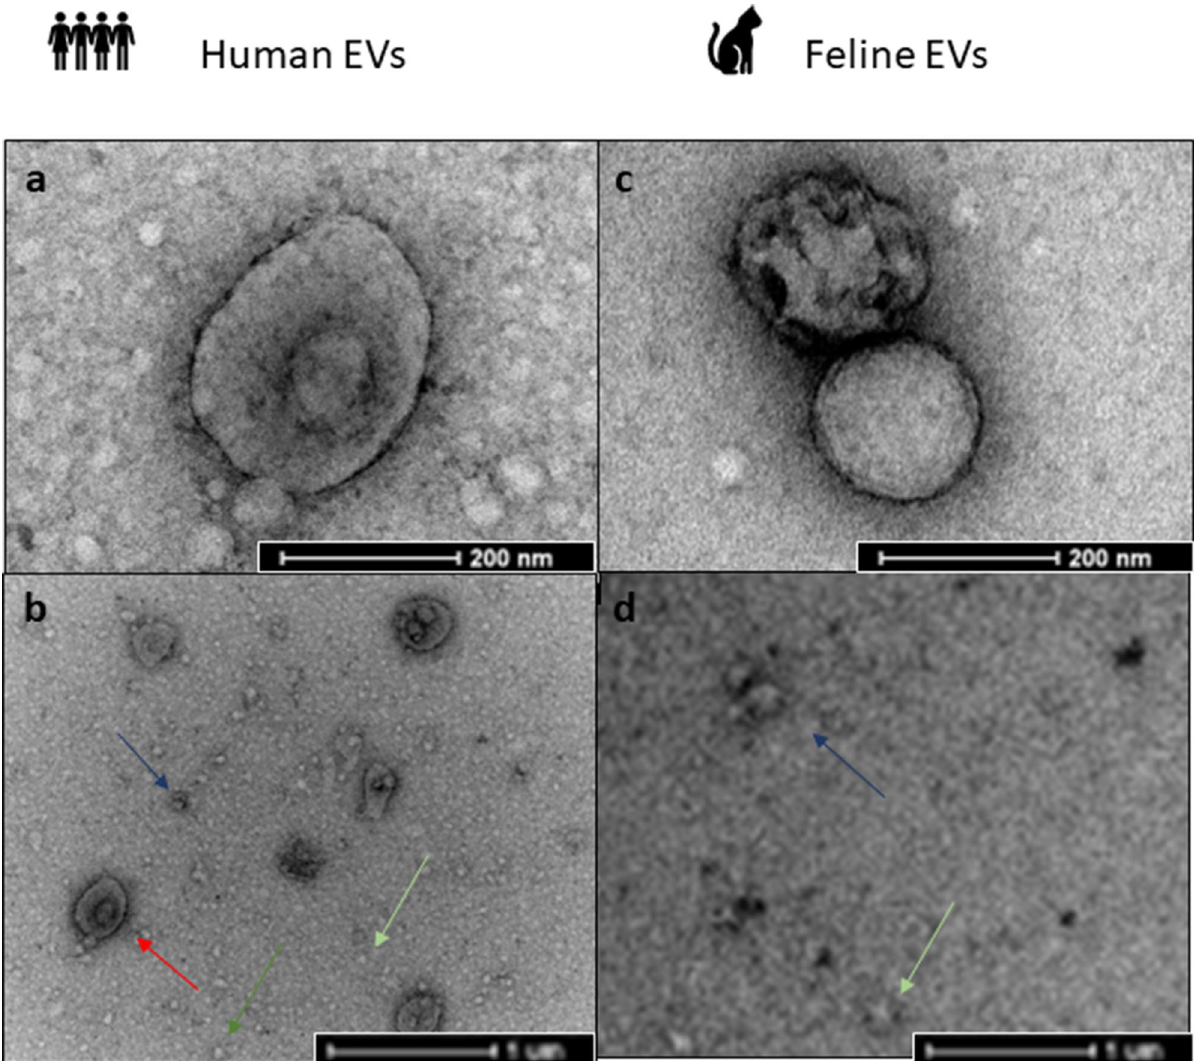
Figure 4. Transmission electron microscopy (TEM) showing the structure of human and feline EVs. (a) Human plasma derived EVs, (magnification × 87,000, scale bar 200 nm) show a small EV around 200 nm in size. (b) Human plasma derived EVs, (magnification × 16,500, scale bar 1 µm) show small EVs indicated in blue as well as a population of larger vesicles indicated in red. Lipoproteins are also visible in green. (c) Feline plasma derived EVs, (Magnification: × 87,000, scale bar 200 nm) shows an example of a small EV around 150 nm in size (blue). (d) Feline plasma derived EVs, (magnification × 16,500, scale bar 1 µm) show a lower density of small EVs (blue) confirming that there is observationally less EVs in feline plasma than human plasma. No larger EVs were visible, while lipoproteins are also visible in